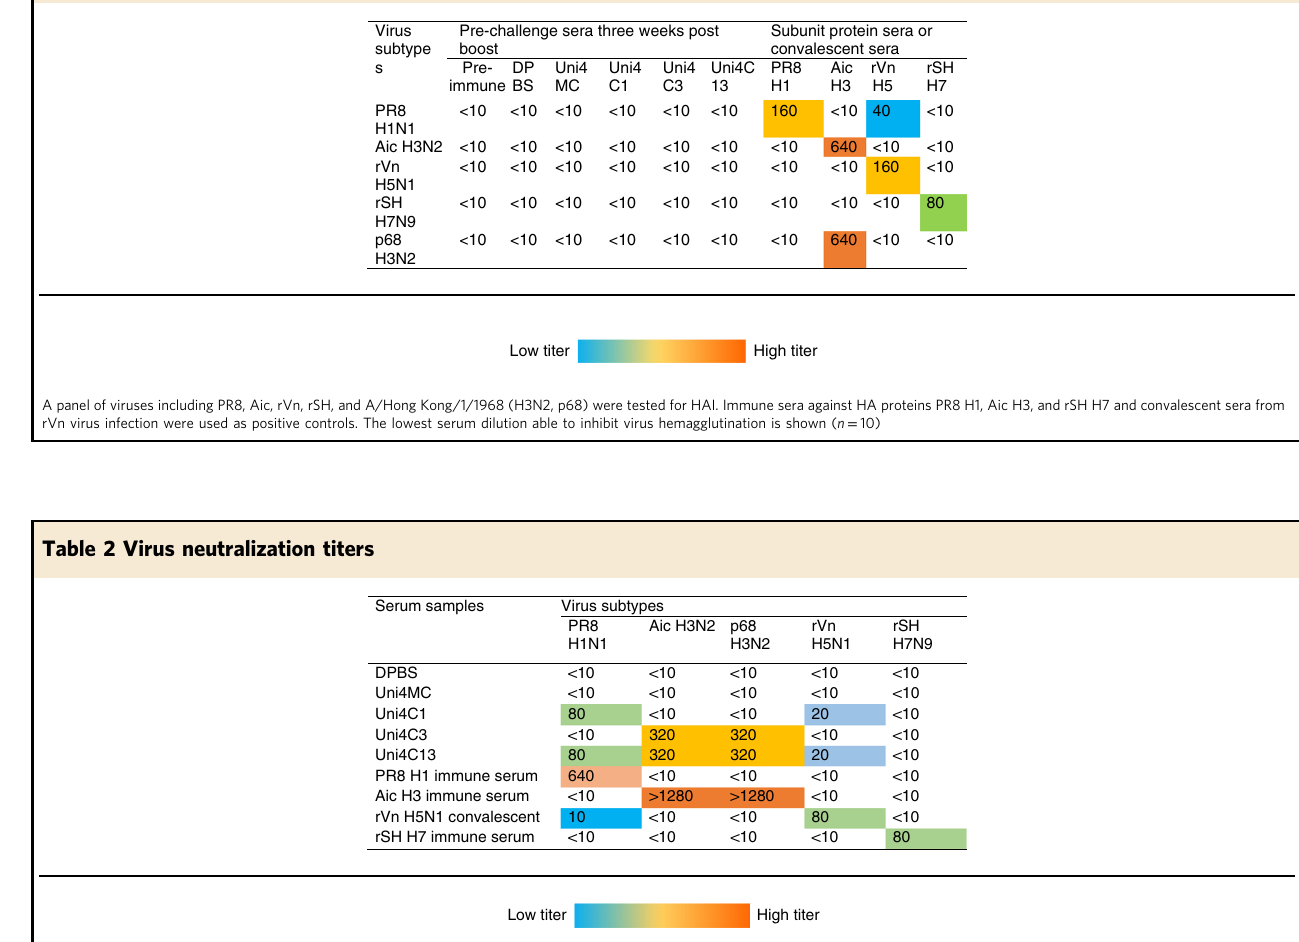
Subunit protein sera or convalescent sera